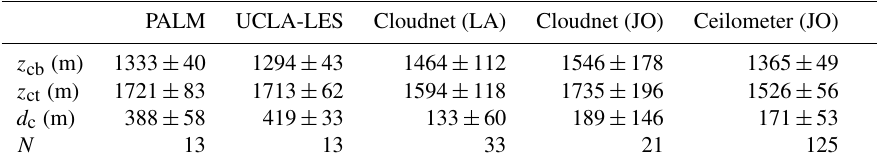
Table 4. Simulated and observed cloud boundaries on 5 May 2013 for 11:00–12:00UTC. PALM